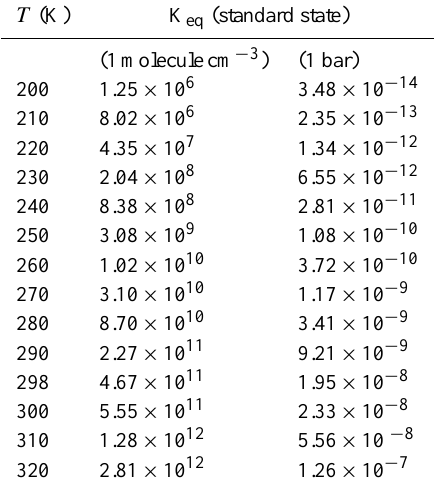
Table 5. Recommended equilibrium constant, K eq ( T ), for Br + Hg → BrHg as a function of temperature for two standard states.